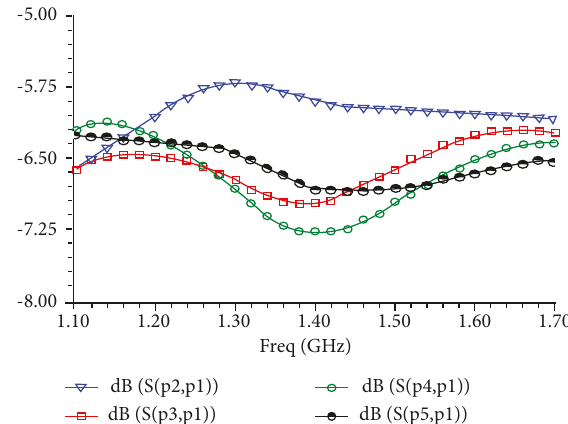
Figure 4: Simulation result of S 21, S 31, S 41, and S